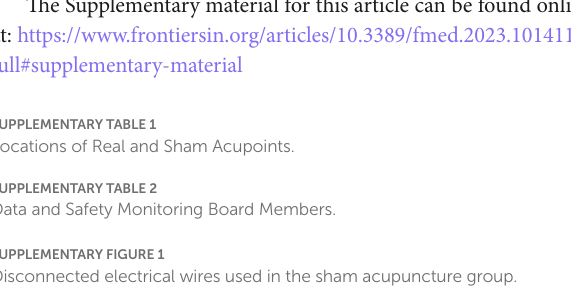
SUPPLEMENTARY TABLE 1 Locations of Real and Sham Acupoints. SUPPLEMENTARY TABLE 2 Data and Safety Monitoring Board Members. SUPPLEMENTARY FIGURE 1 Disconnected electrical wires used in the sham acupuncture